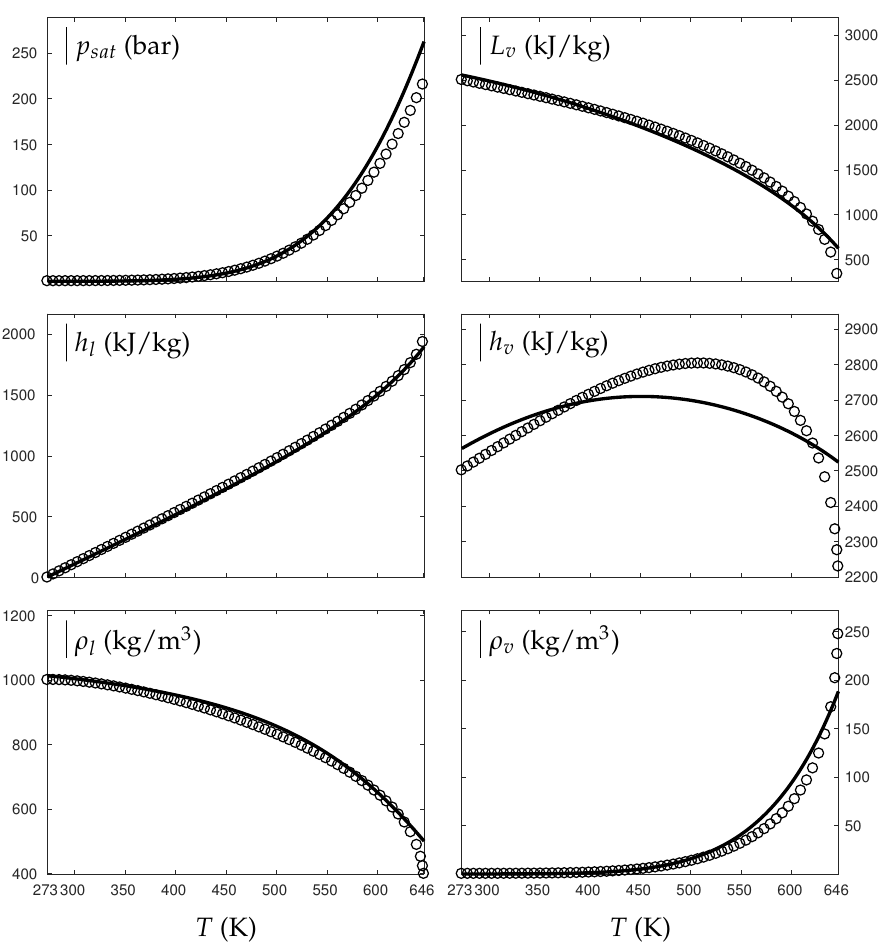
Figure A1. Comparison between experimental and theoretical saturation curves for liquid l and vapor v water. Symbols represent experimental data. The thick lines represent the theoretical saturation curves obtained with the liquid Extended NASG EOS (ENASG) Equation (56) and its “alternative” but conditionally convex formulation for the vapor phase, Equation (A38). p sat denotes the saturation pressure, L v the latent heat, h the specific enthalpy and ρ the density.